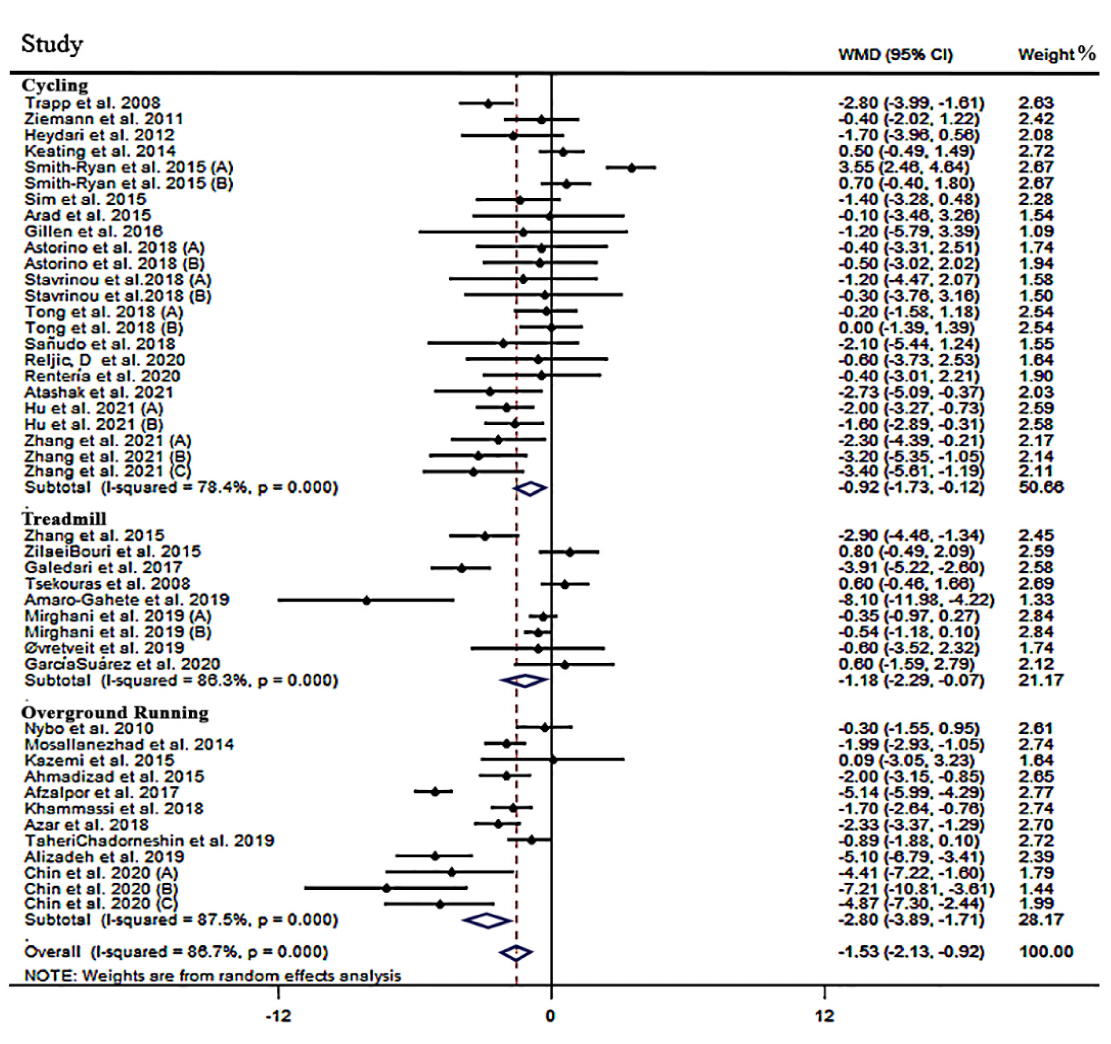
Figure 2. Forest plot detailing weighted mean difference and 95% confidence intervals (CIs) for the effect of high-intensity interval training on